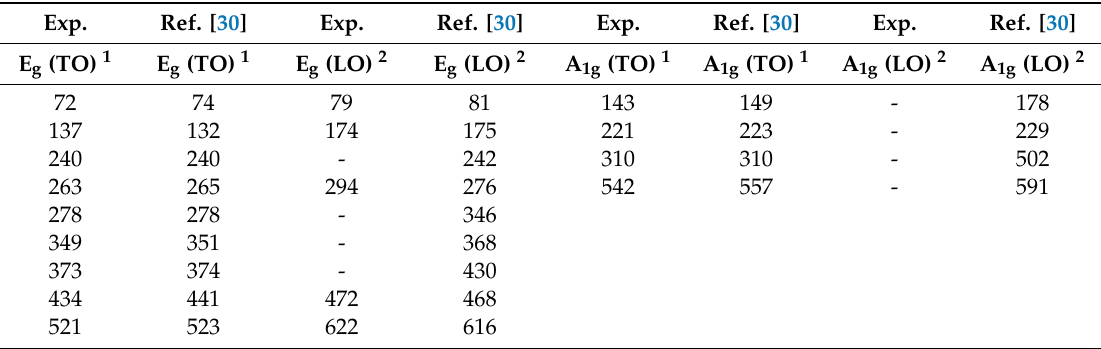
Table 2. Assignment of vibrational modes of BiFeO 3 (in cm − 1 ) [30]. Exp.